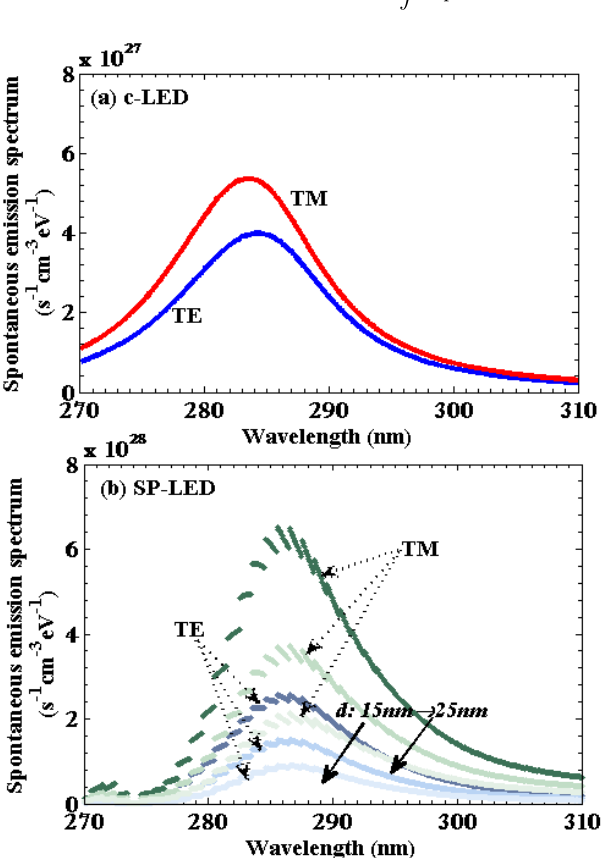
Figure 2. The TE- and TM-polarized SE spectrum of ( a ) c-LED and ( b ) SP-LED. d is the distance between the QW and the Al film.